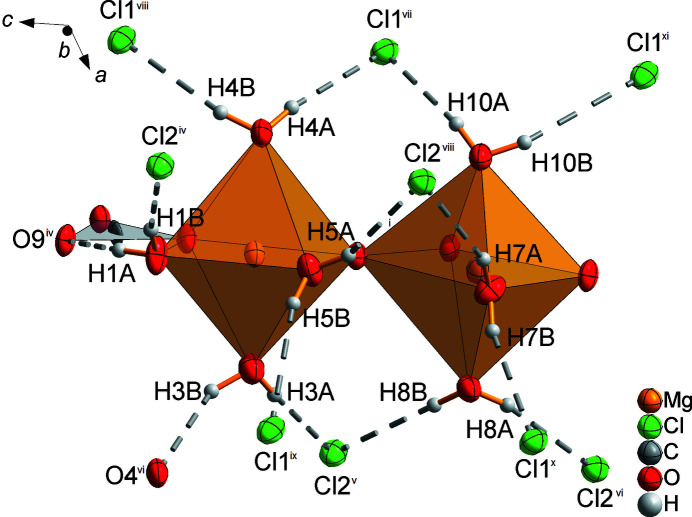
Excerpt of the crystal structure of MgCO3·MgCl2·7H2O, showing the hydrogen-bond inter­actions of the H atoms with chloride ions (dashed lines) [symmetry codes: (iv) x, y, z + 1; (v) x + , y − , z + 1; (vi) x + , −y + , z + ; (vii) x, y − 1, z; (viii) x, −y + 1, z + ; (ix) x + , −y + , z + ; (x) x + , y − , z; (xi) x, −y + 1, z − ].